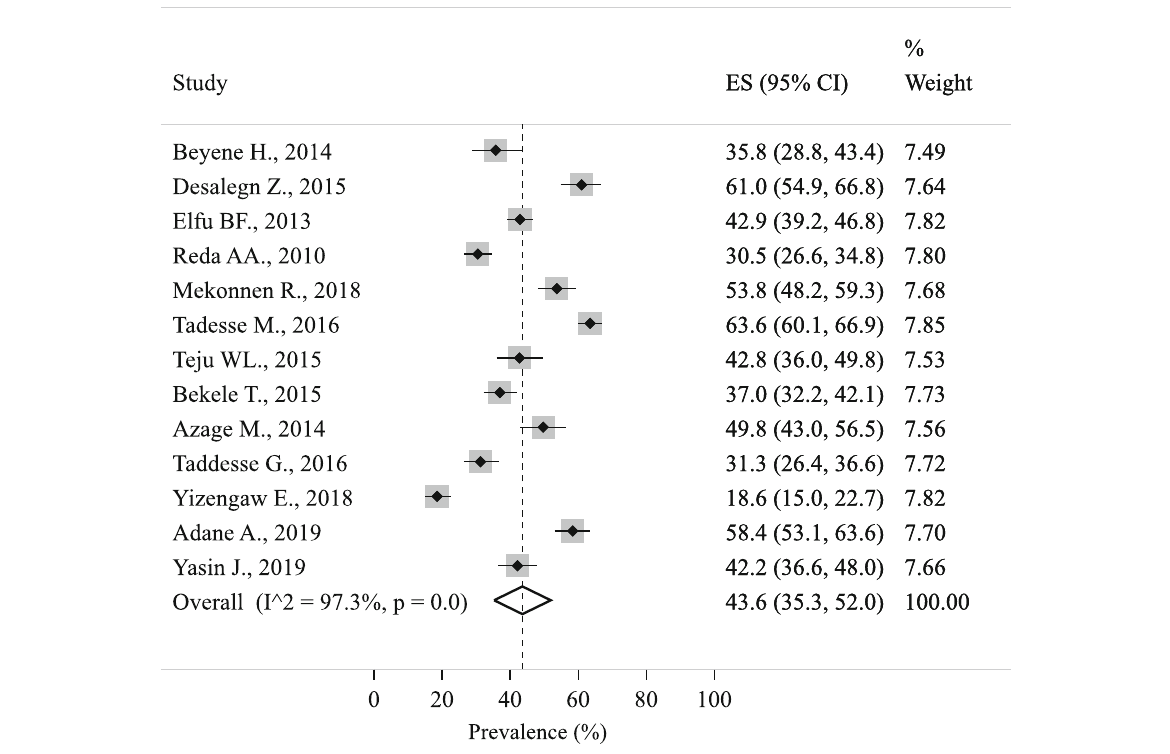
Fig. 3 The lifetime pooled prevalence of needlestick injuries among the Ethiopian healthcare